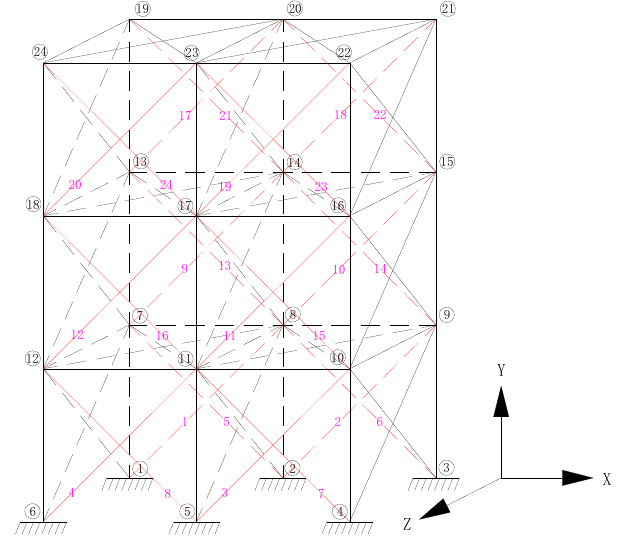
Figure 11. Possible locations of austenitic SMA wires and structural node numbers.